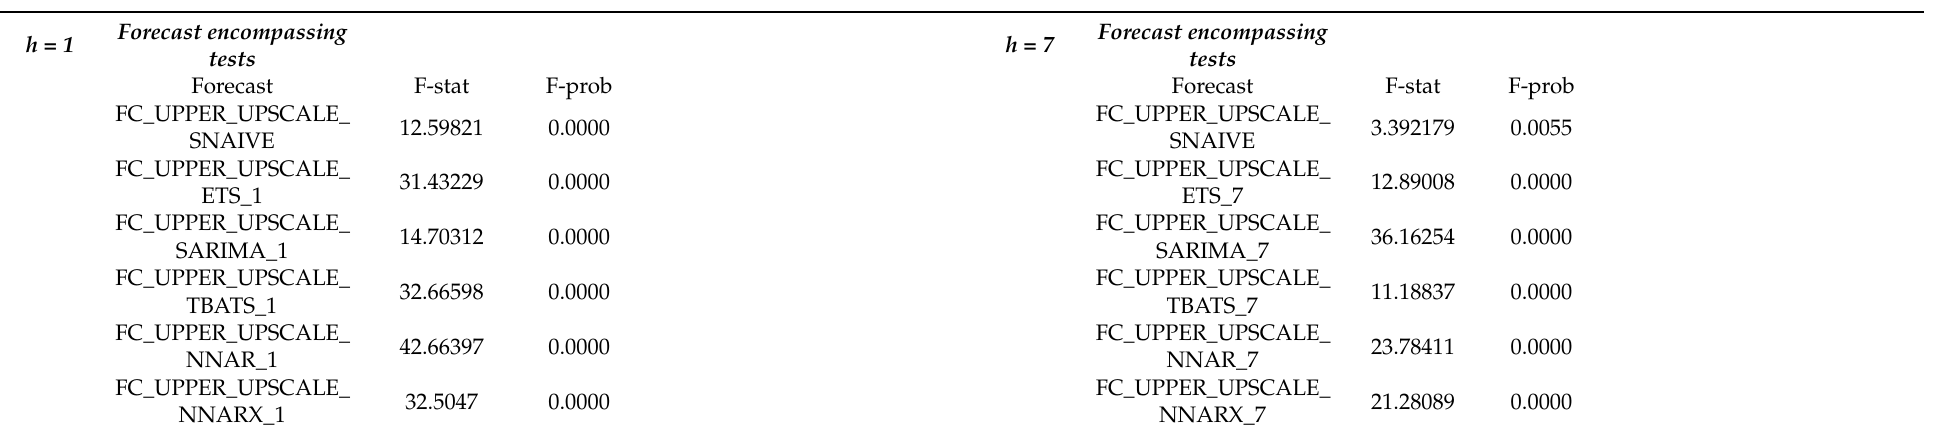
Table A2. Forecast evaluation results for the hotel class ‘upper upscale’. Source: STR SHARE Center, own calculations using R and